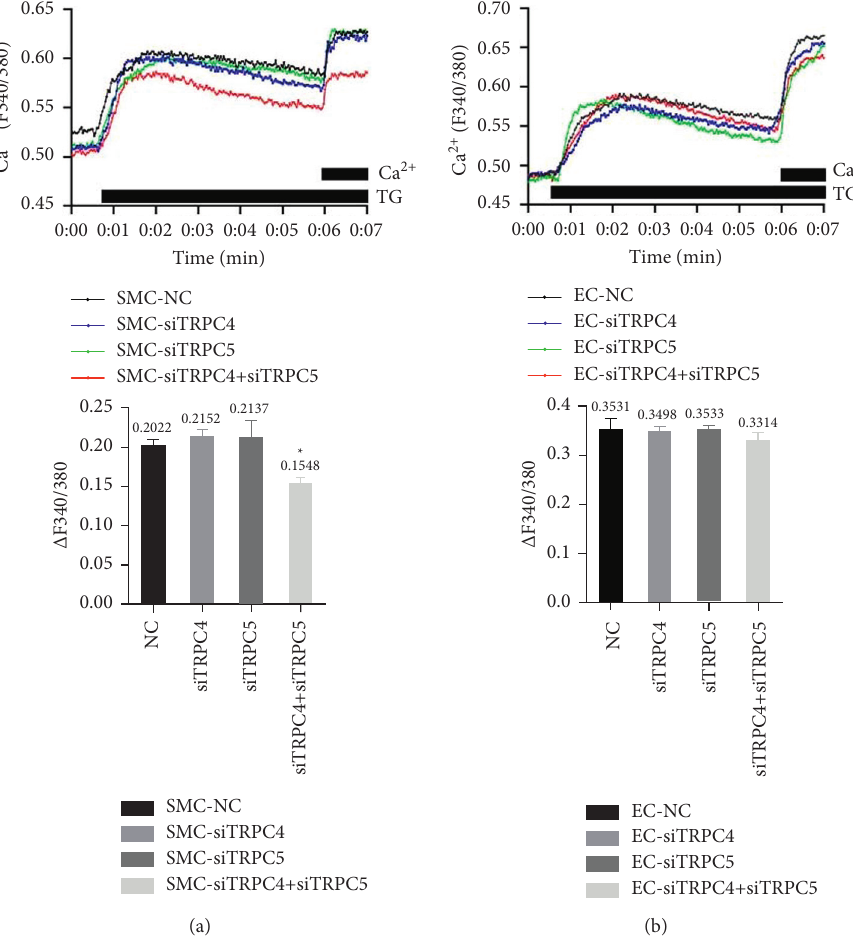
Figure 4: (a) Effects of TRPC knockdown on calcium store depletion in VSMCs. TRPC4, TRPC5, and TRPC4 +TRPC5 were assayed after 7min. Interfering with TRPC4 and TRPC5 together significantly reduced intracellular calcium levels ( N � 6, ∗ p < 0 . 05 vs. scramble siRNA (NC)). (b) Effects of TRPC knockdown on calcium store depletion in VECs. TRPC4, TRPC5, and TRPC4+TRPC5 interference groups were assayed after 7 min. The increase in intracellular calcium ions in each experimental group was essentially restored to the level of the NC group ( N � 6, ∗ p < 0 . 05 vs.